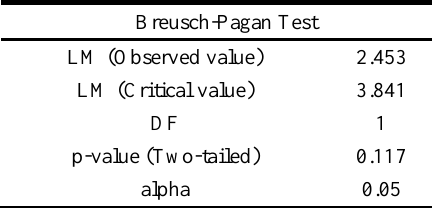
Table 5. Average values of every observed parameter per flight cycle/height interval